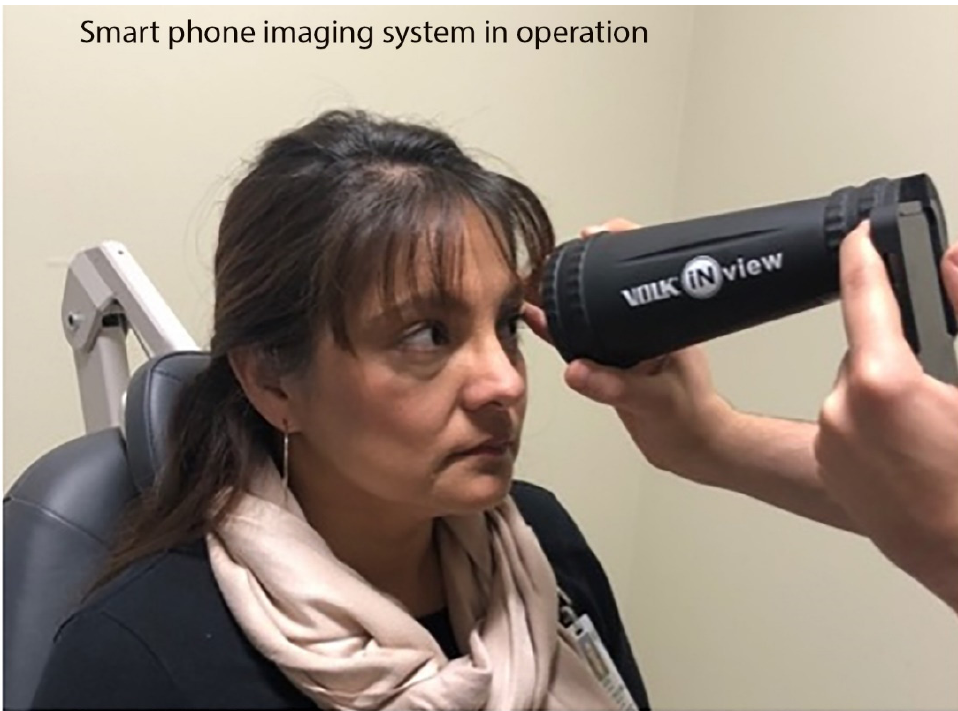
Figure 4. Smartphone Retinal Imager in Operation. Volk iNview Retinal Imager in use, stabilized on a patient’s forehead owing to the BIO lens-like end tube structure allowing for fundus photography to be obtained in any clinical setting without need of a slit lamp or specialized equipment.